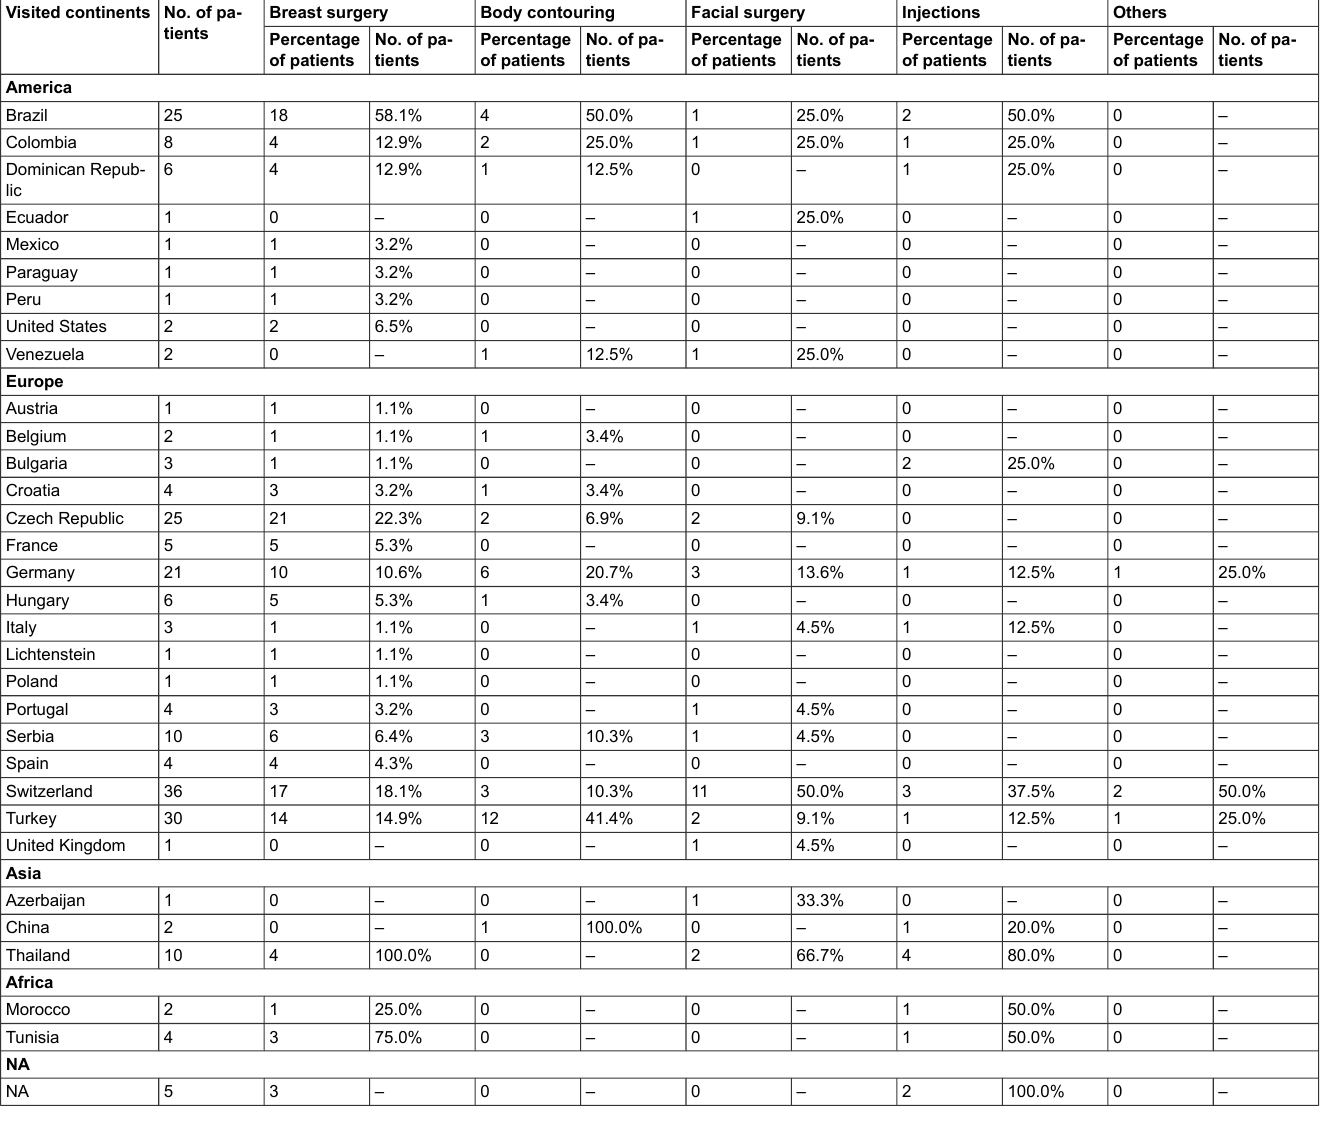
Table 1: Number of performed procedures per country. Visited continents No. of pa-